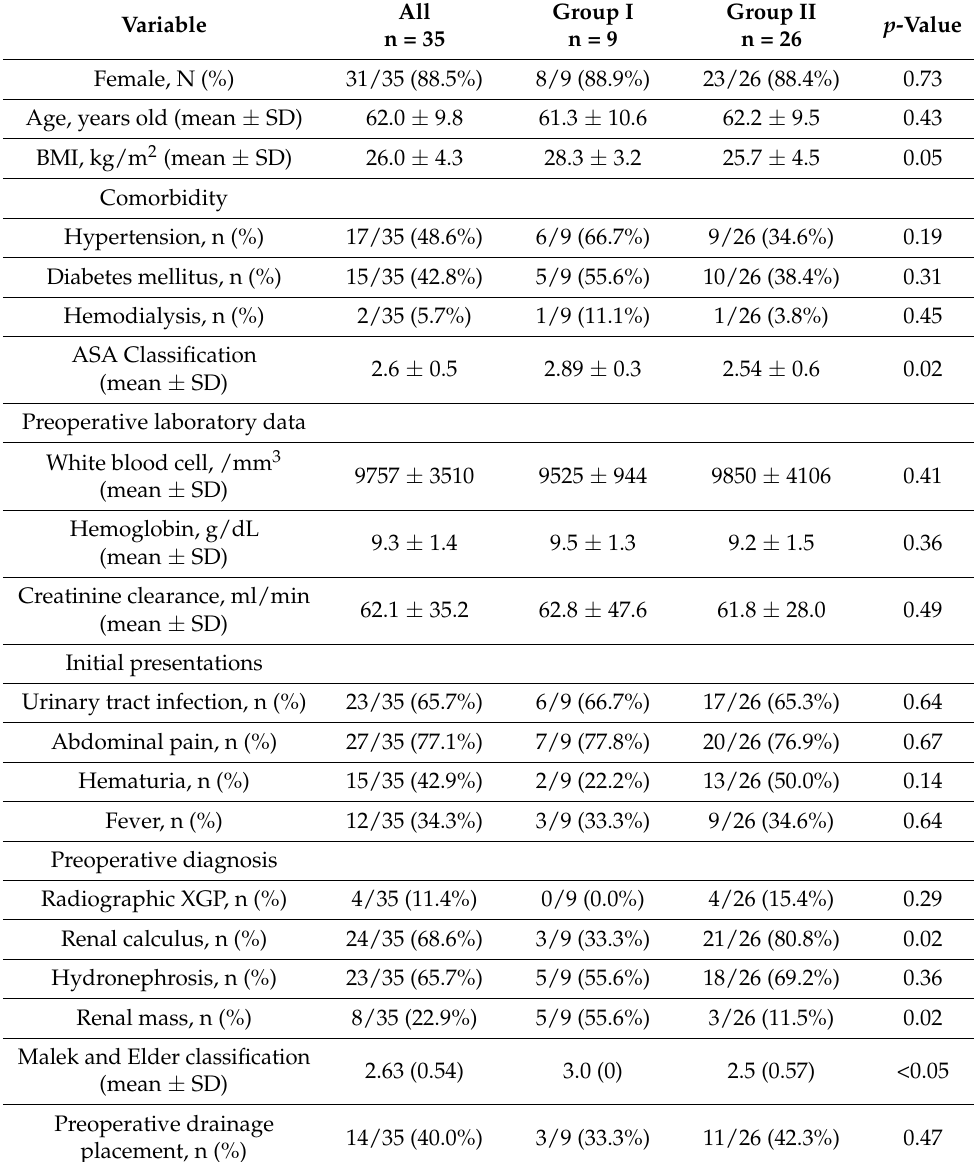
Table 1. Demographic and clinical characteristics of